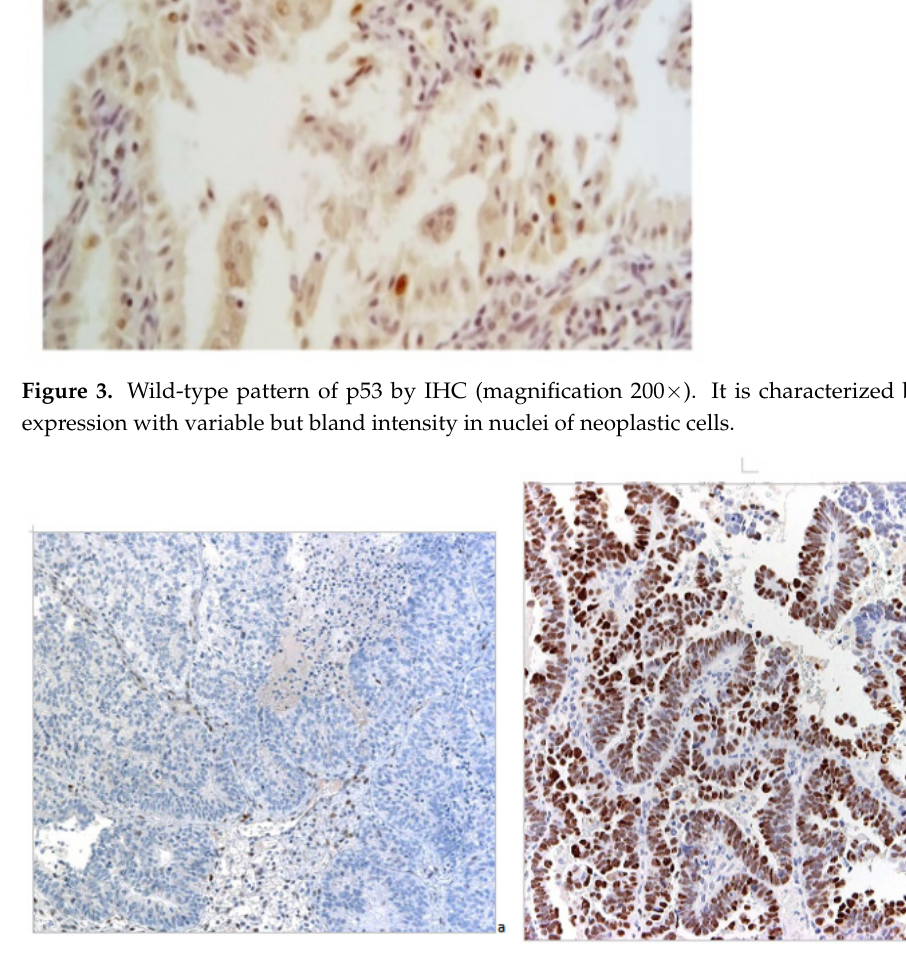
Figure 4. Mutated pattern of p53 by IHC (magnification 100 × ). ( a ) Neoplastic cells have totally lost expression of the protein. ( b ) Neoplastic cells show intense and diffuse nuclear positivity.